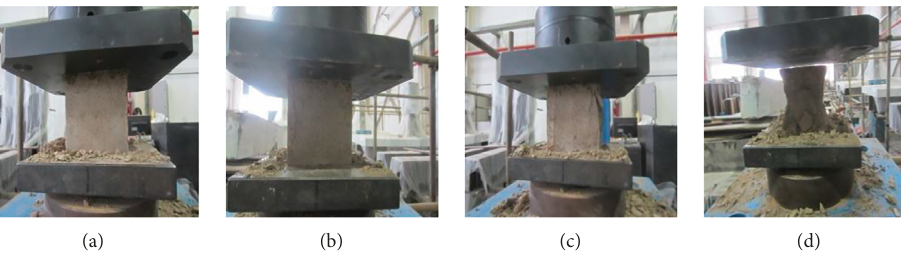
Figure 6: Progress of a sand soil cube compressive strength test. (a) Loading. (b) Cracking. (c) Damage. (d) Completely